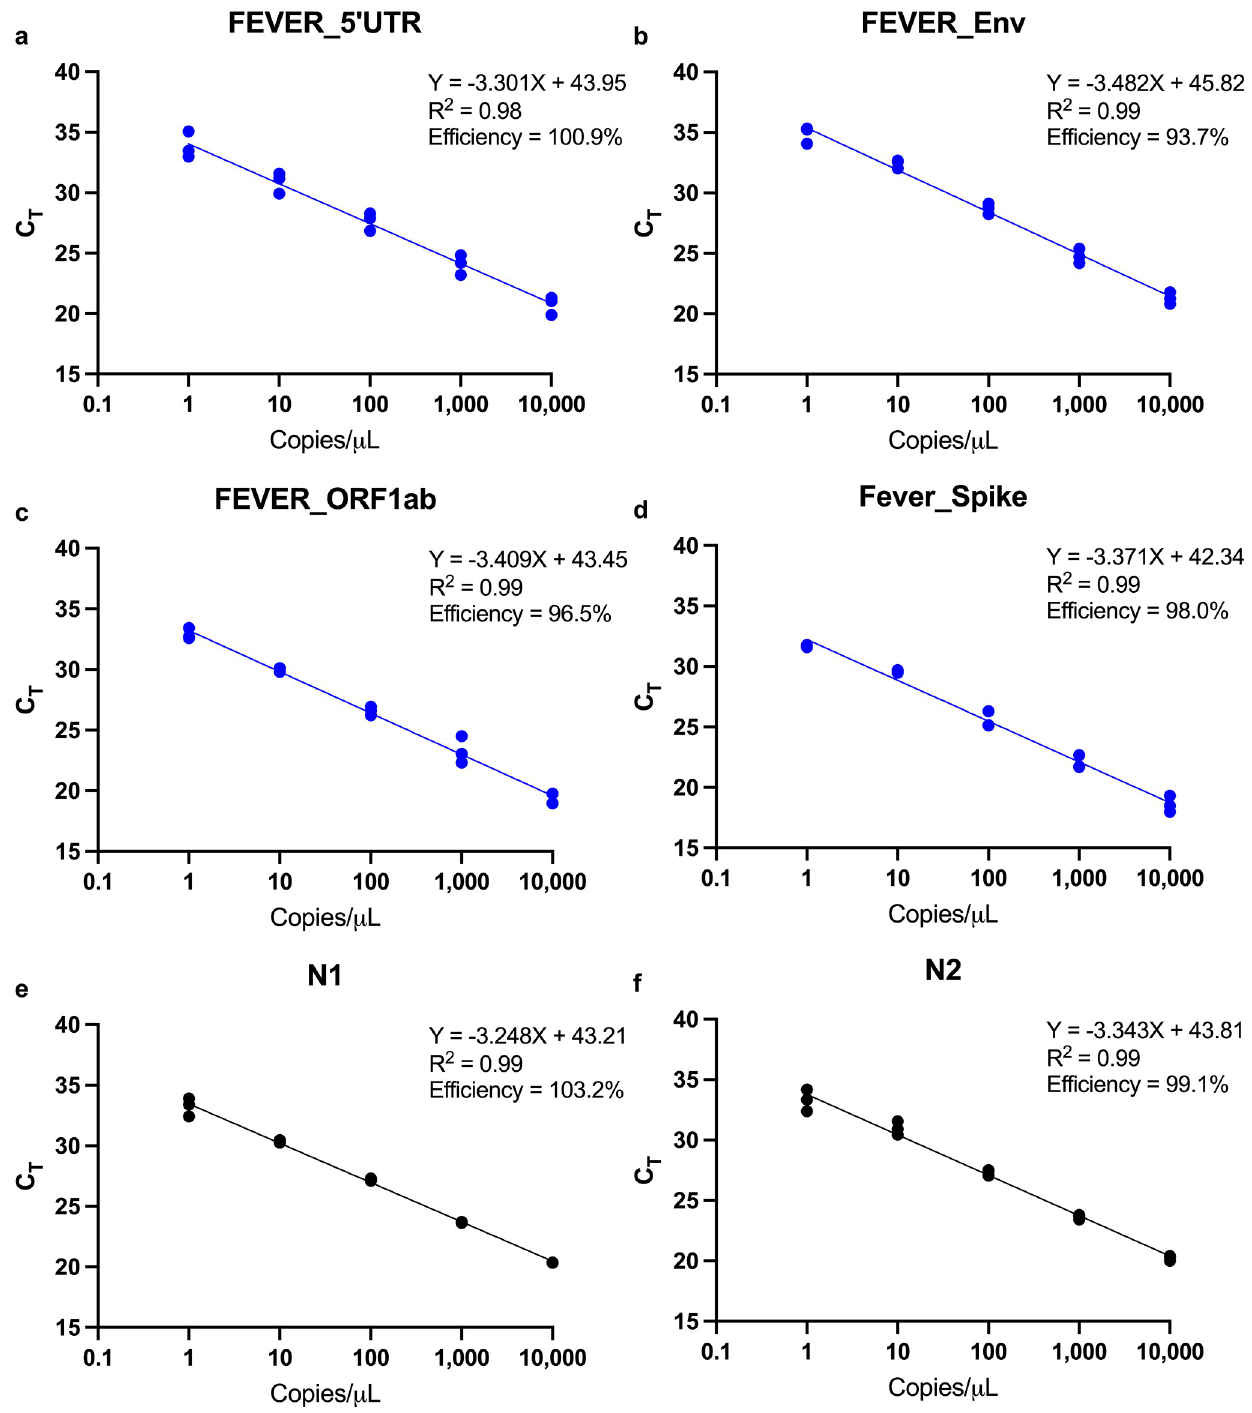
Fig 2. FEVER assays can detect 1 copy/ μ L SARS-CoV-2 spiked into a nasopharyngeal swab sample matrix. Inactivated SARS-CoV-2 strain USA-WA1/ 2020 was spiked into human nasopharyngeal swab samples (confirmed to be SARS-CoV-2 negative) and serial 10-fold diluted from 10 4 to 1 copies/ μ L. Cycle threshold (C T ) values were determined for FEVER assays (blue dots) ( a ) FEVER_5’UTR, ( b ) FEVER_Env, ( c ) FEVER_ORF1ab, and ( d ) FEVER_Spike and the ( a ) N1 and ( b ) N2 assay described by the U.S. CDC (black dots). Each dot within a given concentration is from an independent experiment and a total of three independent experiments were performed for each assay.